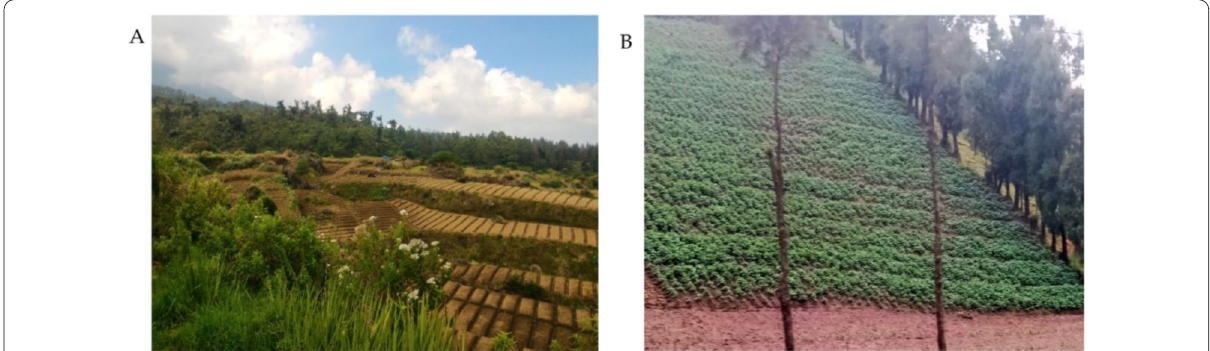
Fig. 14 Picture of mixed shrubs and vegetables ( A ), and mixed vegetables and forest in high percentile slope areas ( B